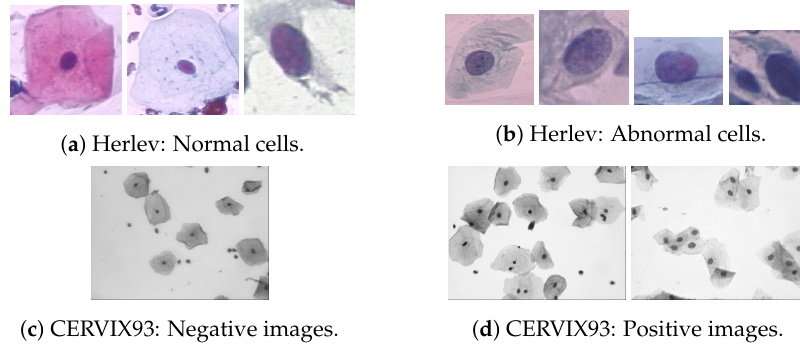
Figure 4. Sample images and corresponding classification of Herlev and CERVIX93 datasets.